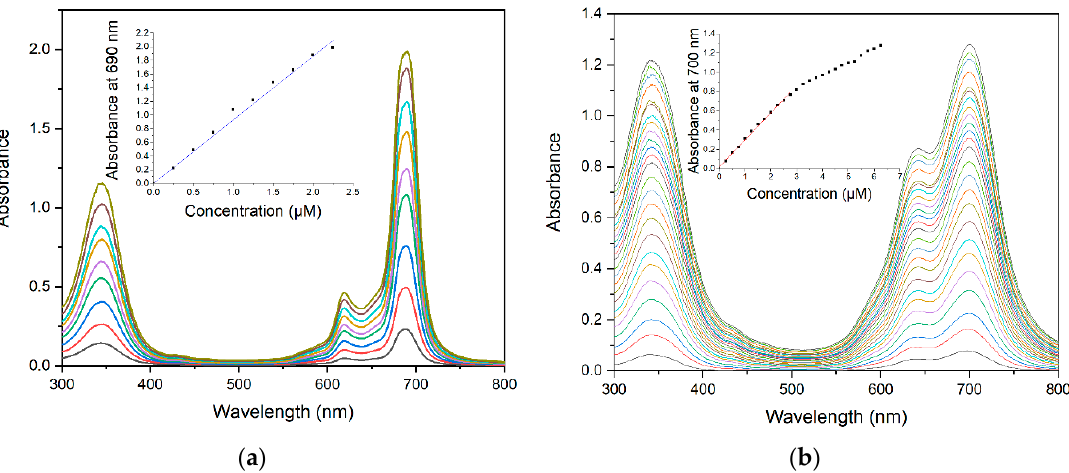
Figure 6. Absorption spectra of different concentrations of bis(DABA)ZrPc in ( a ) DMSO (from 0.25 to 2.2 µM) and ( b ) saline (from 0.25 to 6.0 µM) and the results of Beer-Lambert linearity experiment (insets).